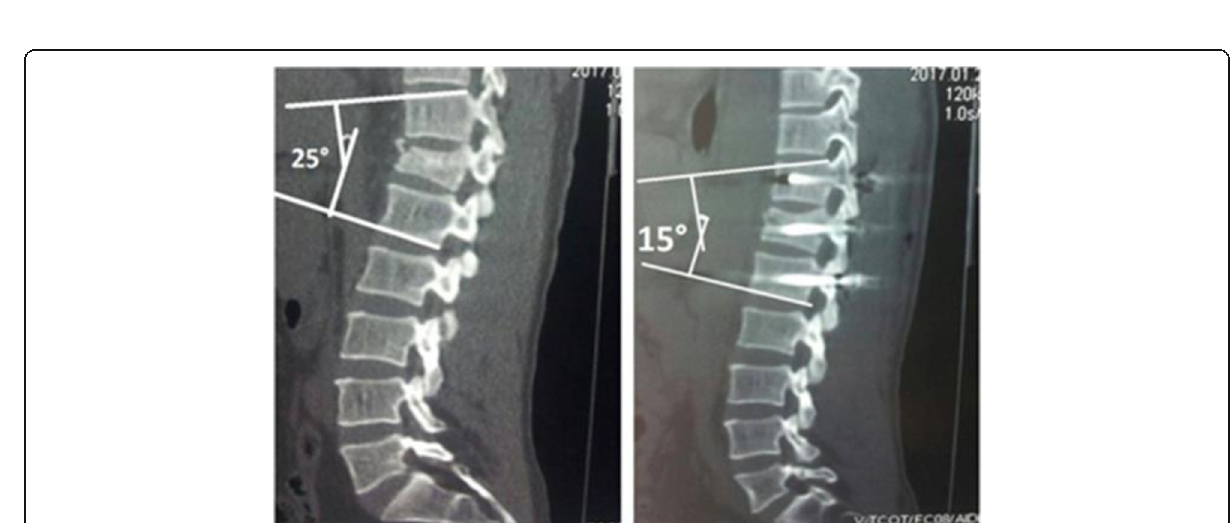
Fig. 17 Preoperative Cobb angle (25°) and immediate postoperative Cobb angle (15°) with correction angle 10°